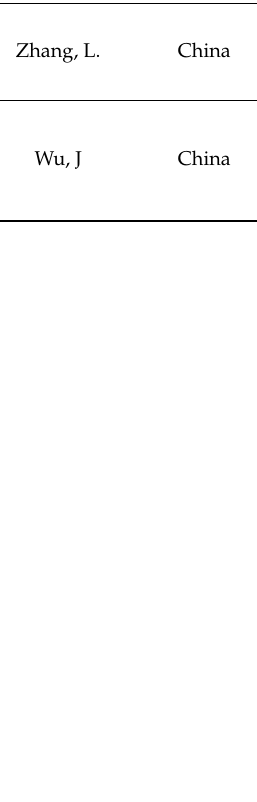
Table 5. Different forms of bee pollen that acts against antimicrobial